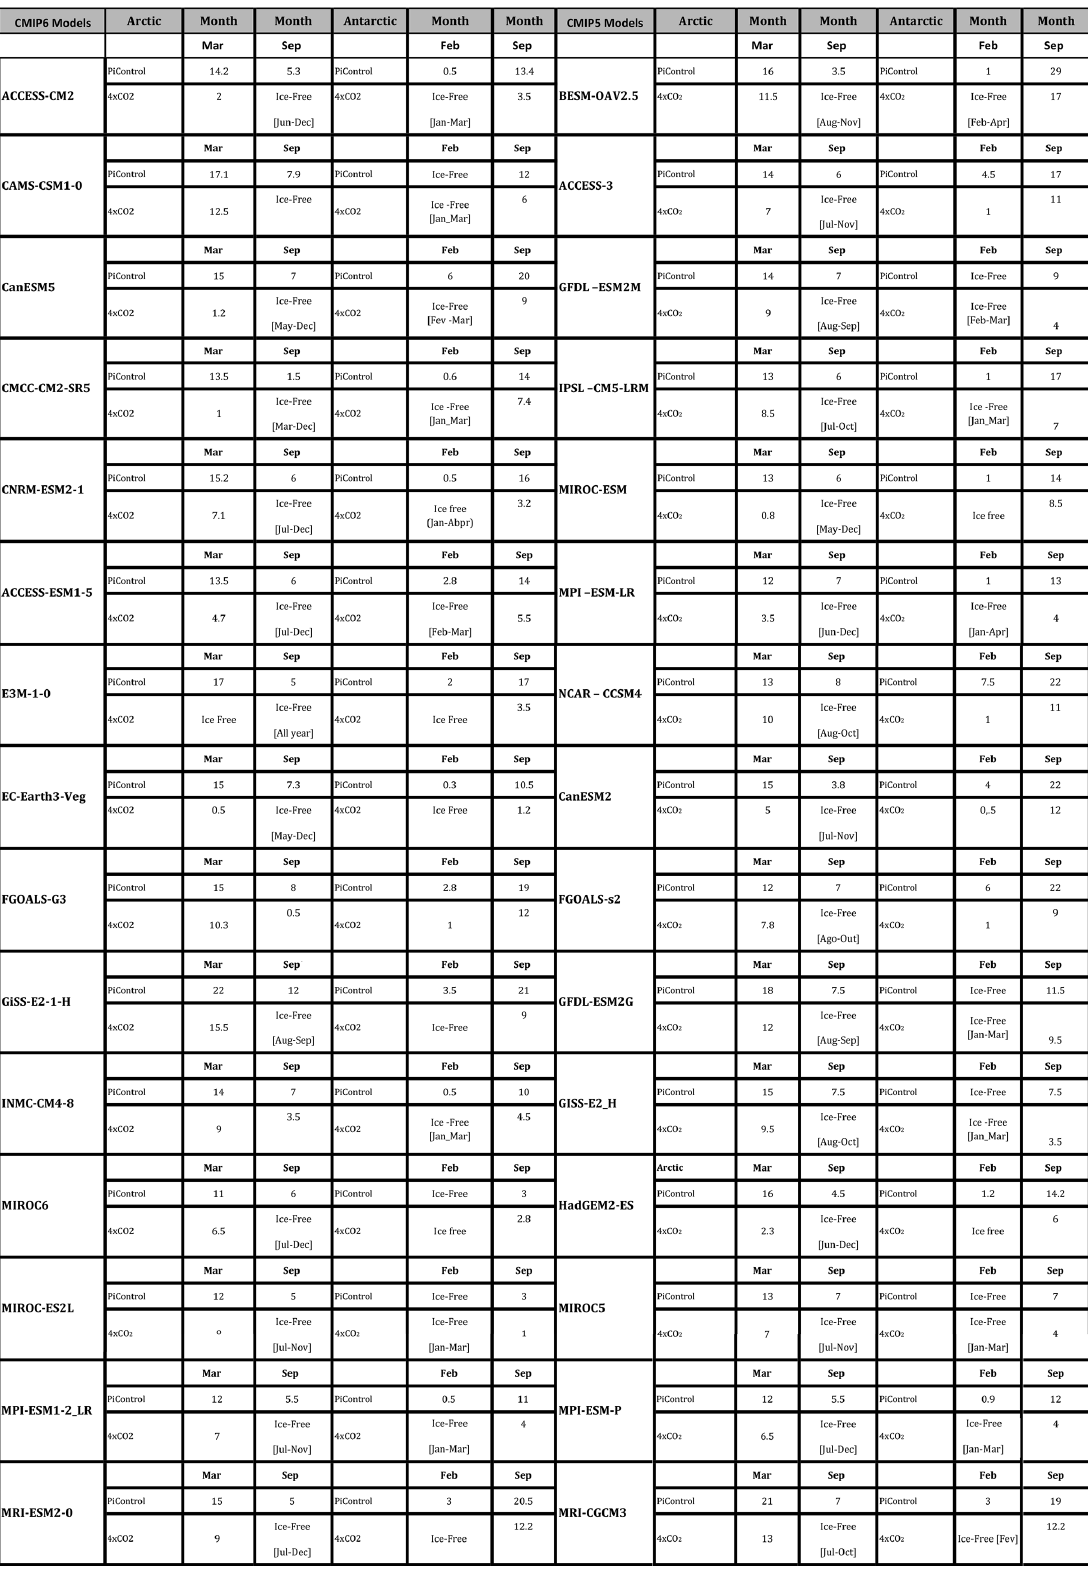
Table 1. Climatology of maximum and minimum sea ice area (million square kilometers) for the last 30 years of the Abrupt-4 × CO 2 numerical experiment and the last 30 years of the piControl run for the CMIP5 and CMIP6